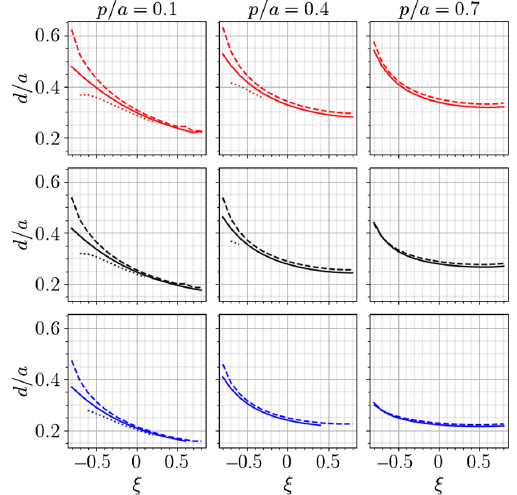
FIG. 6. Corrugation depths calculated for unequal radii corru- gations with ζ ¼ 0 . 85 (dashed), ζ ¼ 1 . 0 (solid), and ζ ¼ 1 . 15 (dotted) where the aperture ratios are a= λ ¼ 0 . 53 (red), a= λ ¼ 0 . 60 (black), and a= λ ¼ 0 . 67 (blue). See Fig. 4 for cell